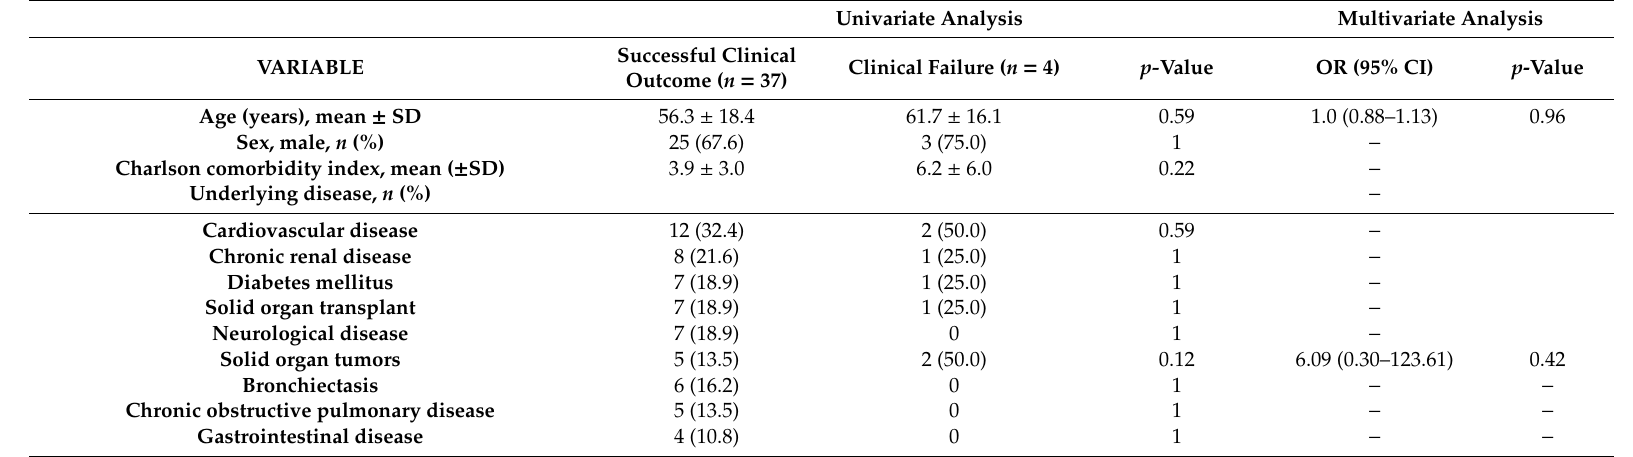
Table 6. Predictors of clinical failure of ceftazidime-avibactam therapy in the study